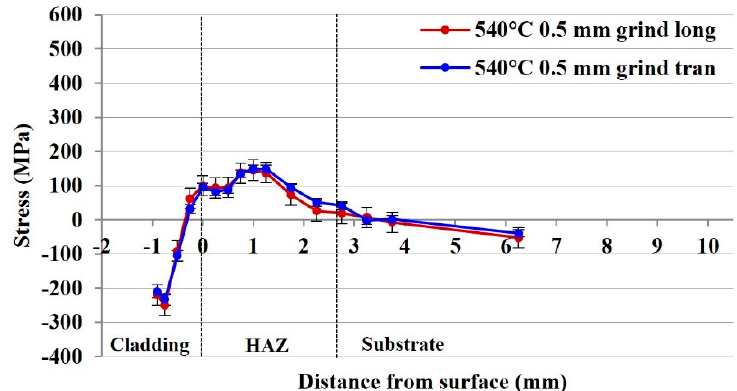
Figure 7. Residual stress distribution of the 540 °C tempered, 415SS clad rail with 0.5 mm surface grinding (log—longitudinal tran—transverse).